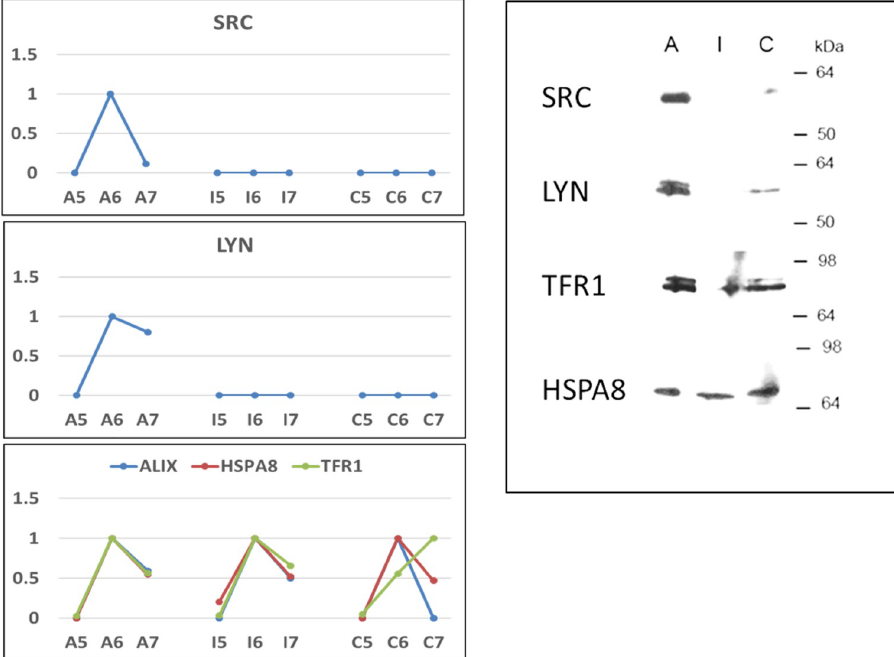
Fig 10. Validation by WB of some exosome markers. We validated the presence of SFK Lyn and Src specifically in active CE samples on a completely independent EXO preparation. On the left are reported the PAPs of EXO markers (Alix, Tfr1, HspA8) and SFK Lyn and Src identified by proteomics as reported in S4 Table. On the right, the WB performed on fraction 6 of new EXO preparation performed from pools of plasma samples (Tab.1) collected at the outpatient clinic for CE of San Matteo Hospital Foundation (Pavia, Italy). These plasma samples were not processed before freezing (not centrifuged at 10,000 x g), and were stored in absence of DMSO. We were able to confirm the presence of EXO markers such as Tfr-1 and HspA8 in all samples, while the presence of Src and Lyn was detected in samples from patients with active CE, at much lower levels in controls, but not in samples from patients with inactive